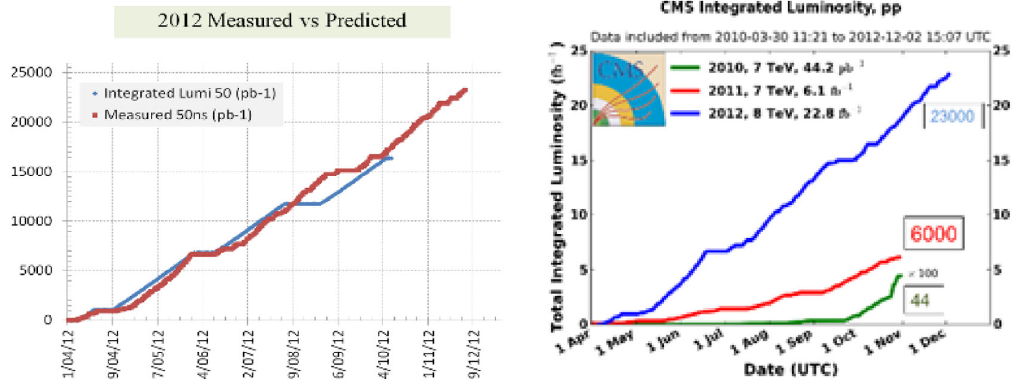
FIG. 30. LHC performance in 2012 (predicted and achieved) and over 2010 to